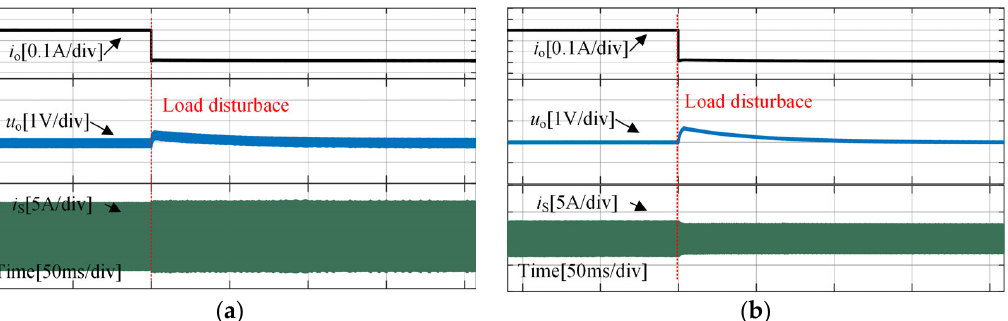
from 100 to 80 V. ( a ) SPS modulation; ( b ) Soft ‐ switching and no backflow power control.